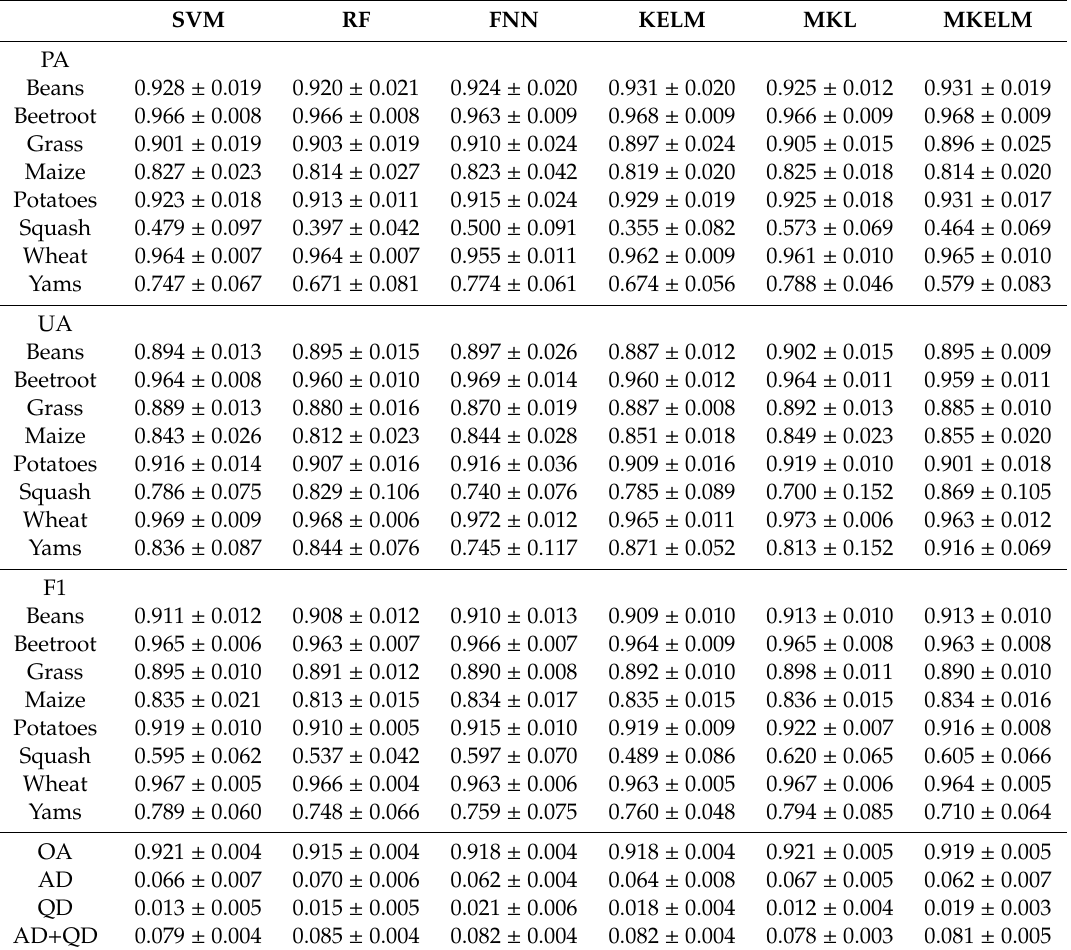
Table 5. Accuracy results for six classification algorithms: support vector machine (SVM), random forest (RF), multilayer feedforward neural network (FNN), kernel-based extreme learning machine (KELM), multiple kernel learning (MKL), and multiple kernel extreme learning machine